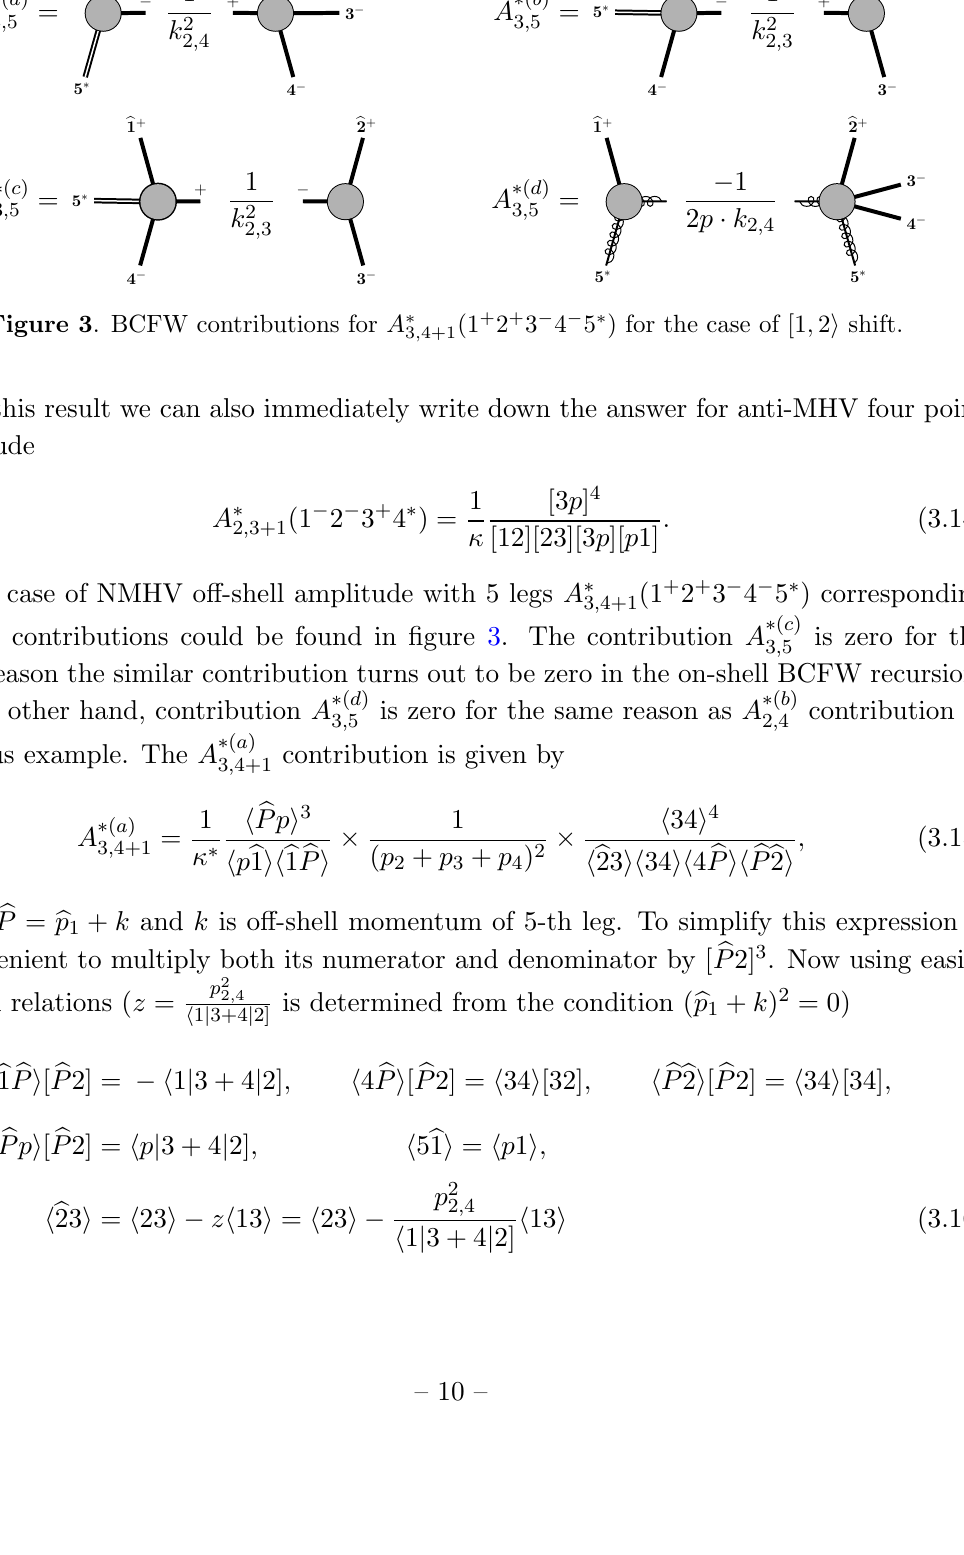
(1 + 2 + 3 (cid:0) 4 (cid:3) ) for the case of [1 ; 2 i shift 2 ; 3+1